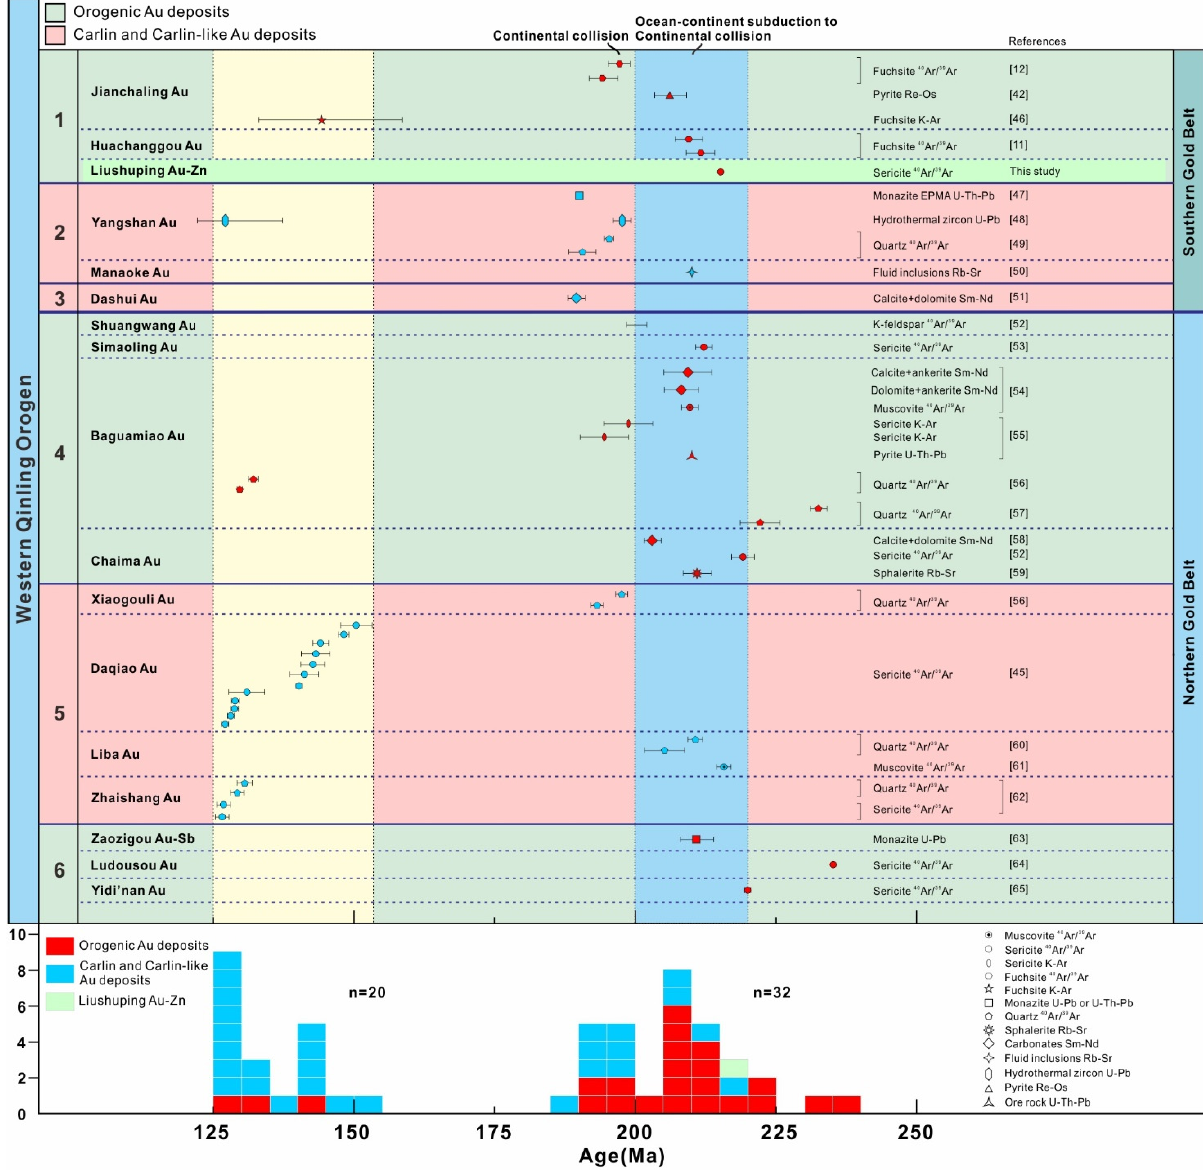
Figure 10. Summary diagram illustrating the ages of Au deposits in the West Qinling Orogen [11,12,42,45,47–65]. Data sources are listed in Table 3. Orogen [11,12,42,45–65]. Data sources are listed in Table